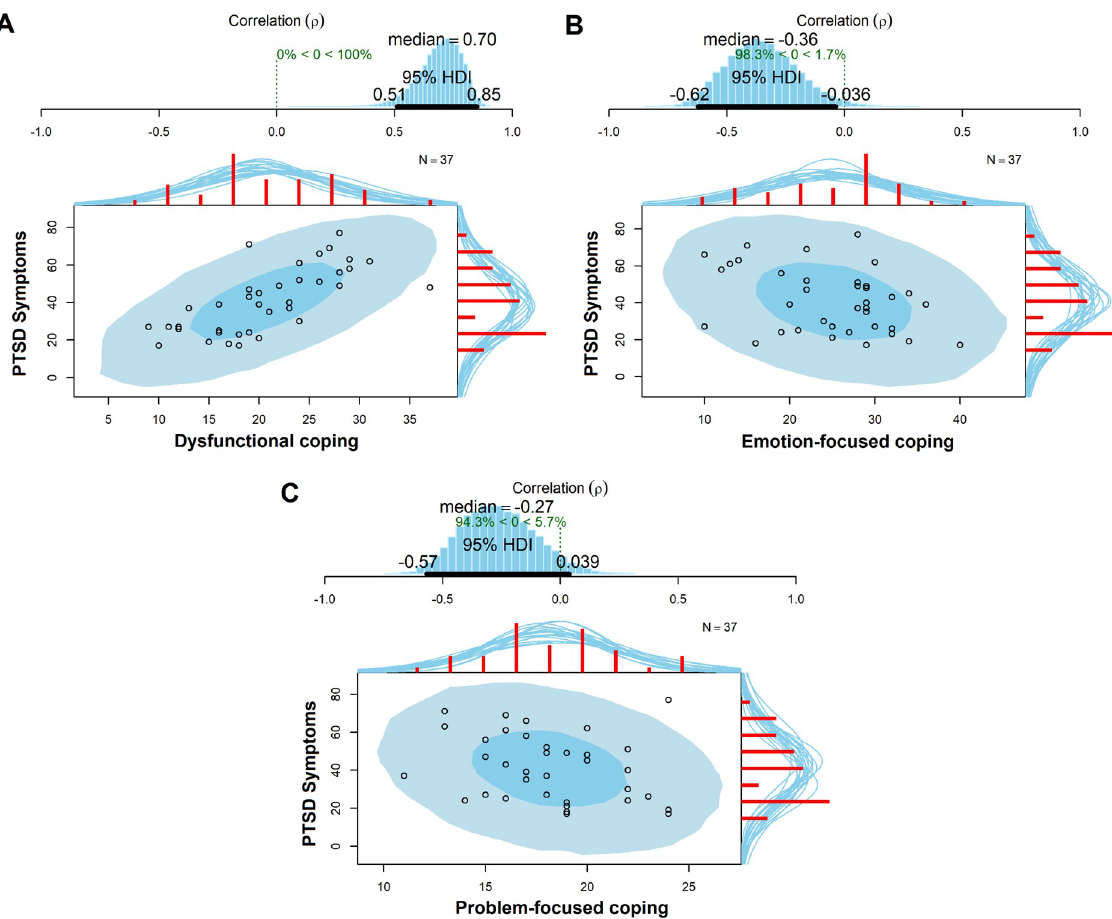
Fig 1. Posterior distributions of the correlation coefficients between PTSD symptoms and coping strategies clusters. Figures A, B and C displays a blue histogram on top showing the posterior distribution of the correlation (p) with a 95% highest density interval (HDI). On the bottom of each figure, we have the superimposed posterior predictive distributions, with the lighter blue showing the 95% highest density region and the dark blue showing the 50% highest density region. The red histograms on top x-axis and right y-axis show the marginal distribution of the data with a smatter of marginal densities drawn from the